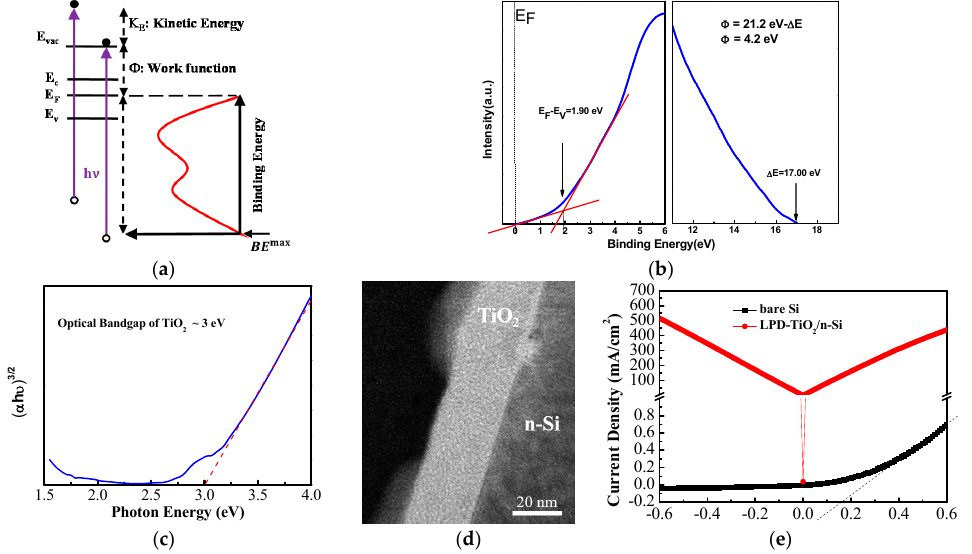
Figure 1. ( a ) Schematic of work function of TiO 2 determined through ultraviolet (UV) photoemission spectroscopy (UPS) spectroscopy; ( b ) UPS spectrum of liquid phase deposition (LPD) ‐ TiO 2 ; ( c ) optical bandgap of TiO 2 layer; ( d ) image of TiO 2 /Si interface taken through transmission electron microscopy (TEM); and ( e ) I ‐ V characteristics of Al/LPD ‐ TiO 2 /Si diode.